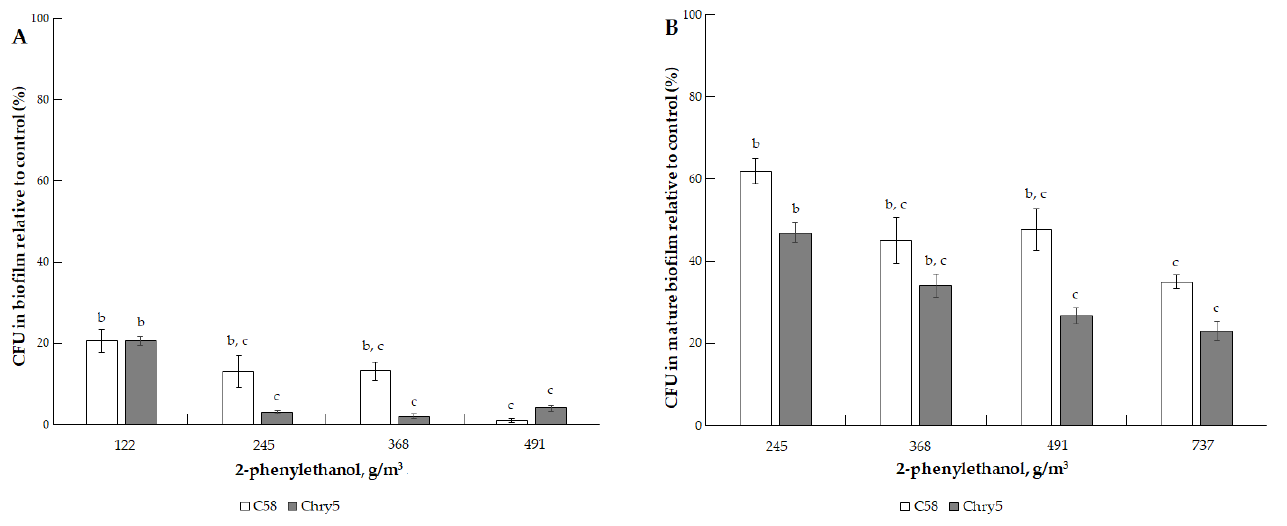
Figure 6. The effect of isoamyl alcohol on the formation of biofilm of A tumefaciens C58 (white column) and Chry5 (gray column) ( A ) and cell survival in mature biofilms of the C58 strain ( B ) and Chry5 strain ( C ) depending on the concentration of isoamyl alcohol. CFU of bacteria strains in the (no effect on C58 at doses of 145.15–580.6 g/m 3 ) (CFU of Chry5 was 50% at 580.6 g/m 3 ) control (without VOC): 100 a %. The different lowercase letters above the mean values indicate sig- (Figures 3B and 4B). nificant differences ( p ≤ 0.05; Tukey’s HSD test).